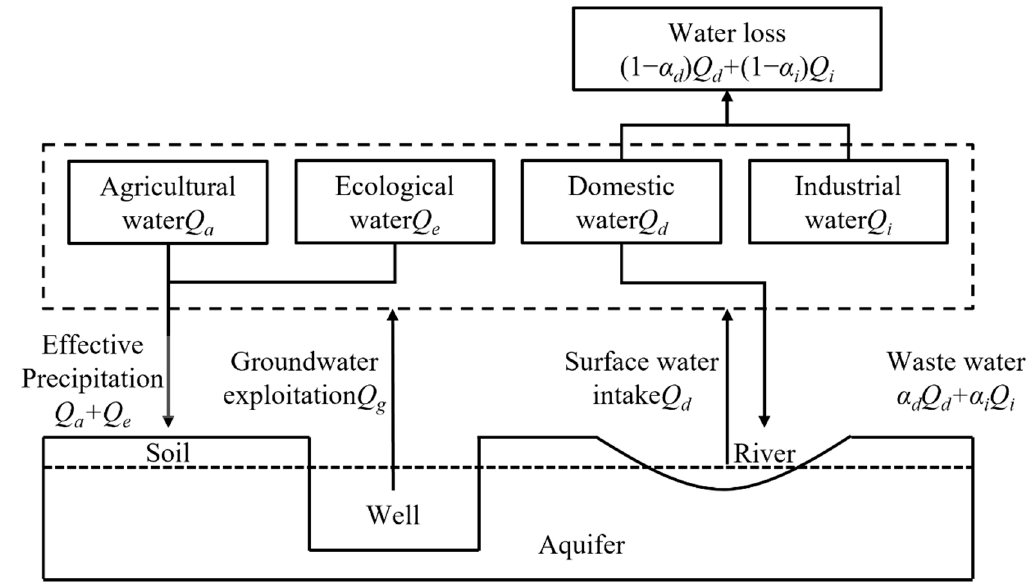
Figure 2. Artificial water withdrawal scheme.